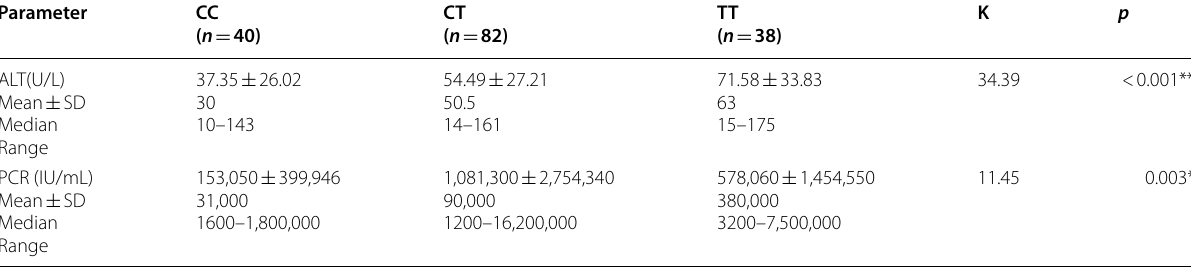
ALT: alanine aminotransferase PCR: polymerase chain reaction SD: standard deviation K Least significant difference (LSD) of ALT between genotypes: (CC versus CT p (CC versus CT